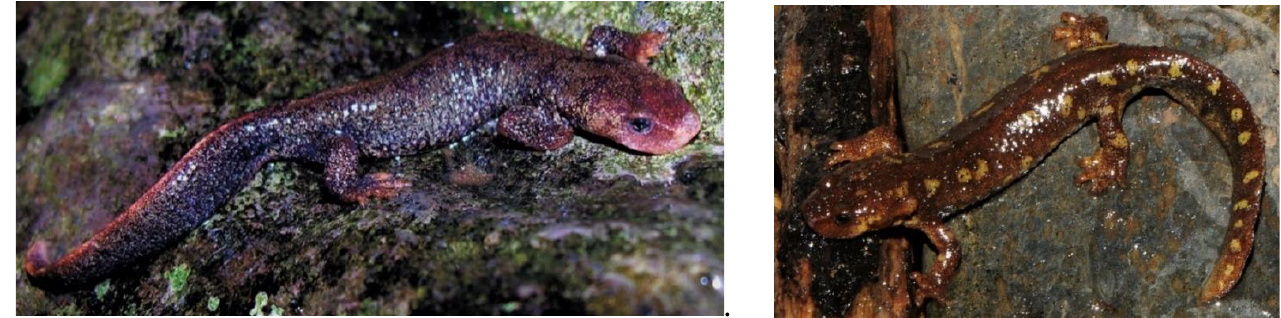
Figure 2. ( Right ) Male of eastern subpopulation. ( Left ) Male of western subpopulation.